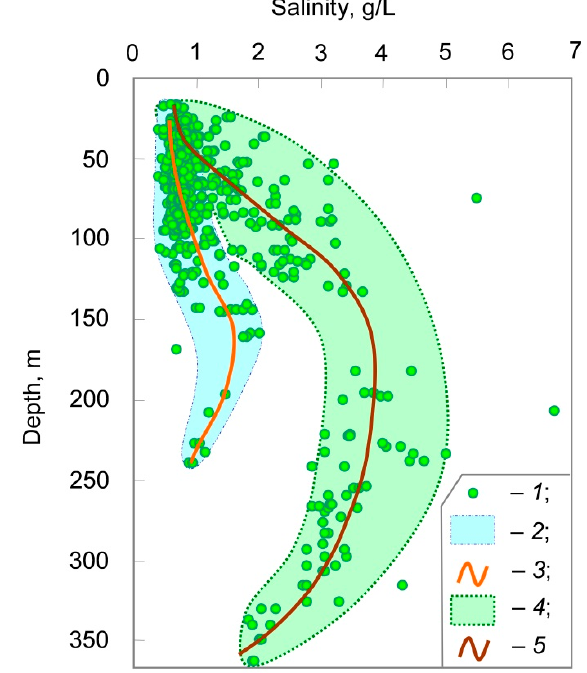
Figure 4. Vertical chemical zonation of groundwater in the Pre-Volga region (results of sampling of 839 boreholes in 1990–2005): 1 —individual analysis (“Depth” on the ordinate is mean a middle depth of the borehole screen); 2 , 3 —field of groundwater mineralization of the Mesozoic structural stage and approximation line; 4 , 5 —field of groundwater salinity of the Upper Permian structural stage and the approximation line. River valleys are the most probable areas for the upward discharge of brackish deep- water. Such anomalies are simultaneously observed in the groundwater salinity, the